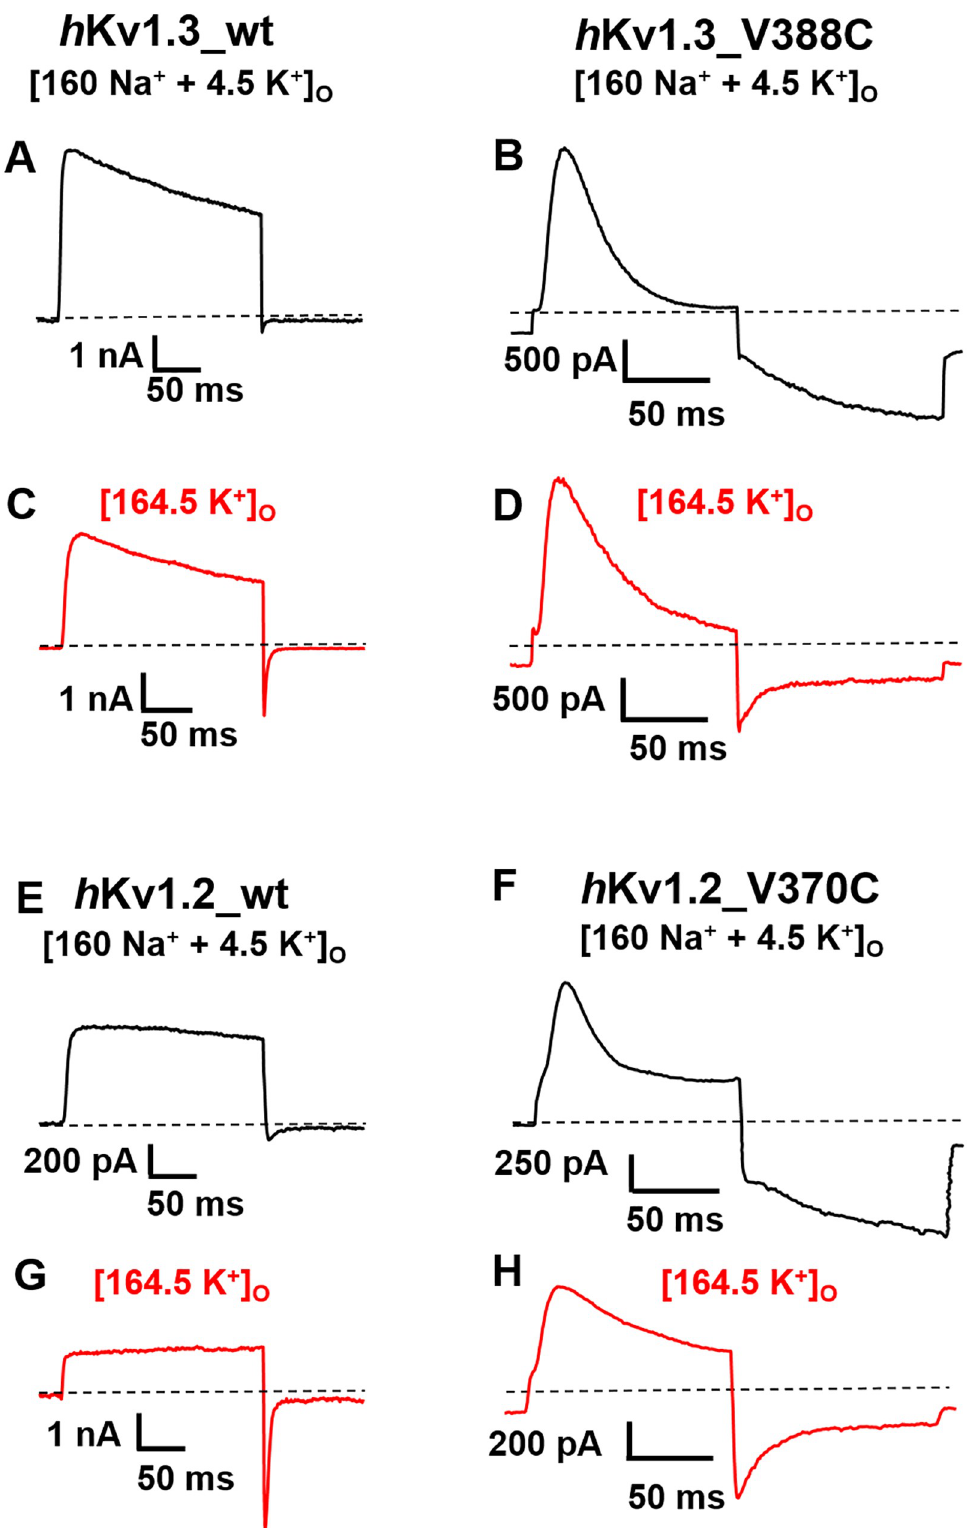
Fig 2. Similarity of inward current in h Kv1.2_V370C and h Kv1.3_V388C mutant channels. Currents through wt h Kv1.3 ( A , C ), wt h Kv1.2 ( E , G ), h Kv1.3_V388C ( B , D ) and h Kv1.2_V370C ( F , H ) channels